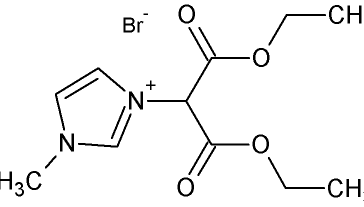
Figure 2. Chemical structure of reactive ionic liquid (RIL) used in this research, 3-(1,3-diethoxy-1,3- Table 1. Chosen physicochemical properties of water, ethanol, and propan-2-ol.